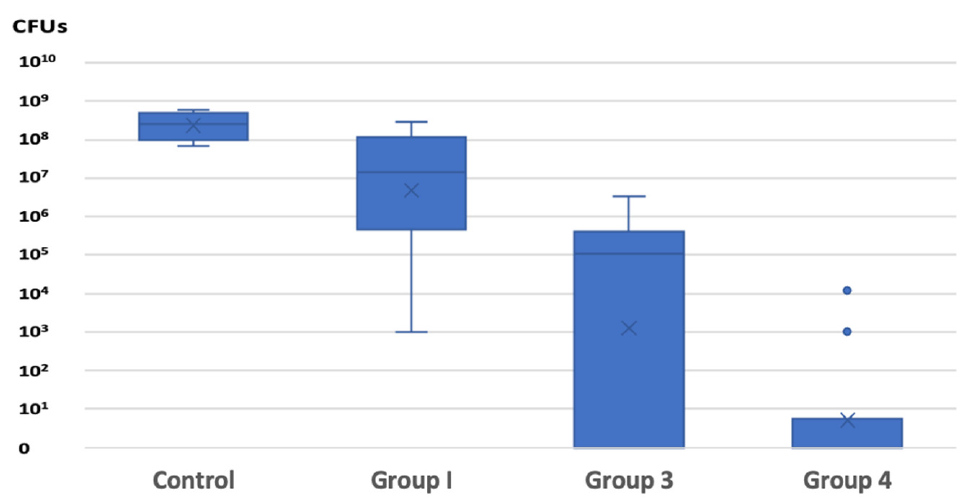
Figure 10. Box and Whittaker graph of the CFUs from each group shows an overall decrease in CFUs in correlation to the number of layers with the greatest reduction in 4-MLTRPB. A three-fold reduction in bacteria was noted in group 4, which can be considered clinically significant.